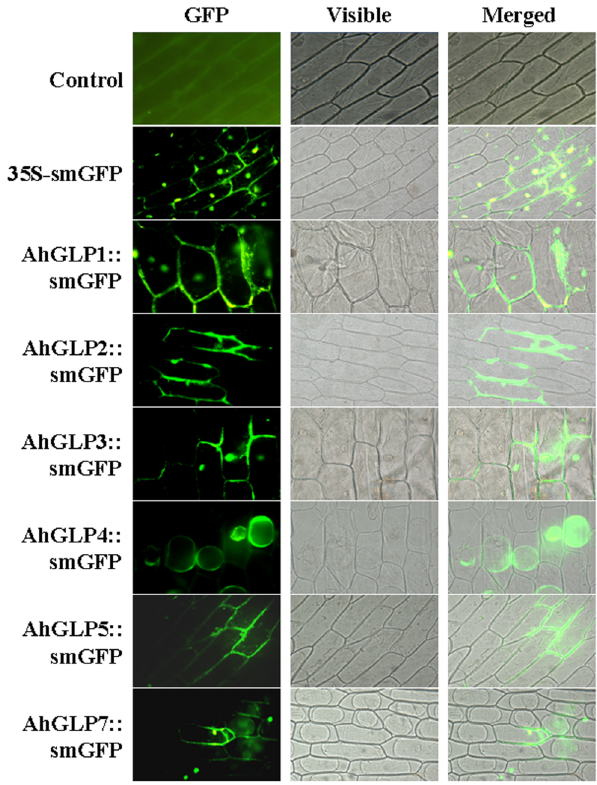
Figure 2. Subcellular localization of AhGLPs-GFP proteins in onion epidermal cells. Localization of AhGLPs-GFP fusion protein. Control: fluorescence of onion epidermal cells under empty vector. 35S- smGFP: onion epidermal cells expressing the GFP gene only driven by he 35S promoter. GFP fluorescence and differential interference contrast images and Visible/GFP merged images are shown from left to right.